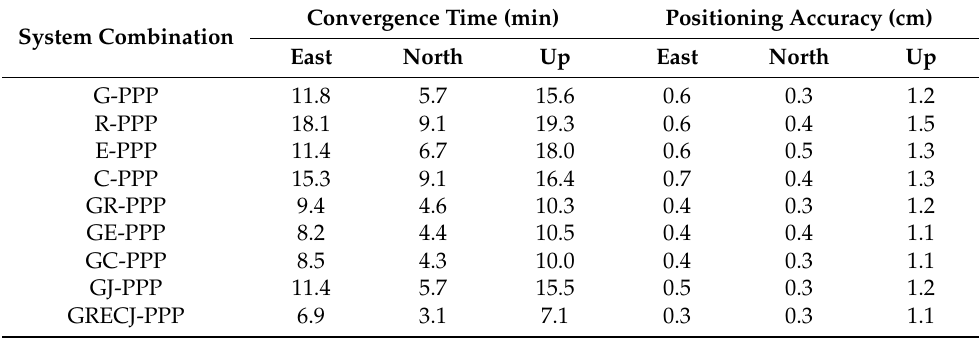
Table 10. Static positioning accuracy and convergence time of post-processed PPP (long-term perfor- mance of PPP based on daily observations) with GFZ products for different system combinations using the datasets from 29 stations spanning a